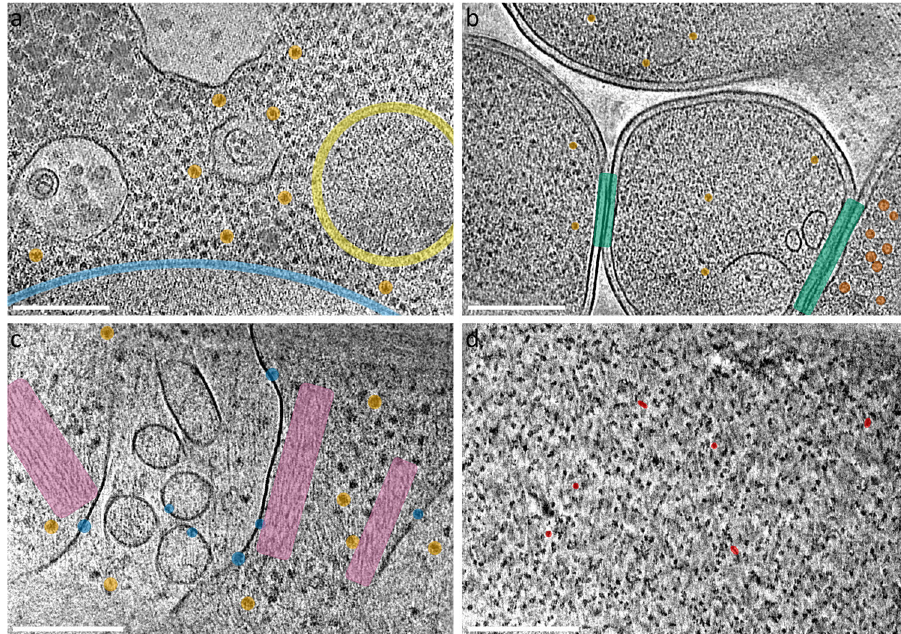
Fig. 4 Additional examples using the Waf fl e Method. Tomogram slice-through of: a of yeast S. cerevisiae with several ribosomes (orange), potential mitochondria (yellow), and the nuclear envelope (light blue) highlighted; b E. coli BL21 (DE3) + Leviviridae PP7-PP7 virus capsid proteins with several virus capsids (red-orange), ribosomes (orange), and neighboring cell-cell membranes (green) highlighted; c HEK 293 S GnTI- with several transmembrane proteins (blue), ribosomes (orange), and actin networks (purple) highlighted; and d porcine thyroglobulin (ThG) single particle waf fl e lamellae with several orientational views highlighted (red). Scale bars are 200 nm. Each slice shown is about 8 Å thick. n > 25 a , 35 b , 5 c , and 10 d independent